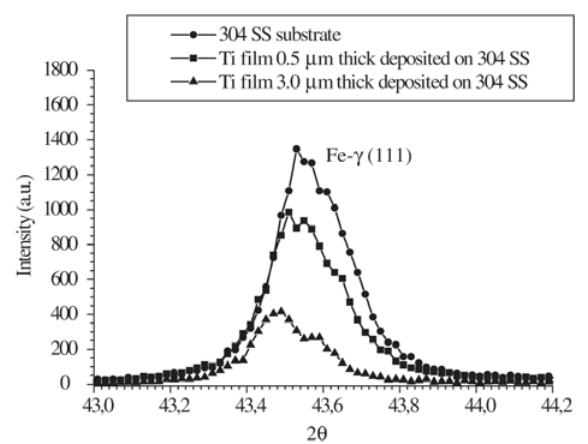
Figure 3. XRD patterns for the 304 SS surface without film and titanium films deposited with 0.5 µ m and 3.0 µ m thick by electron beam on 304 SS